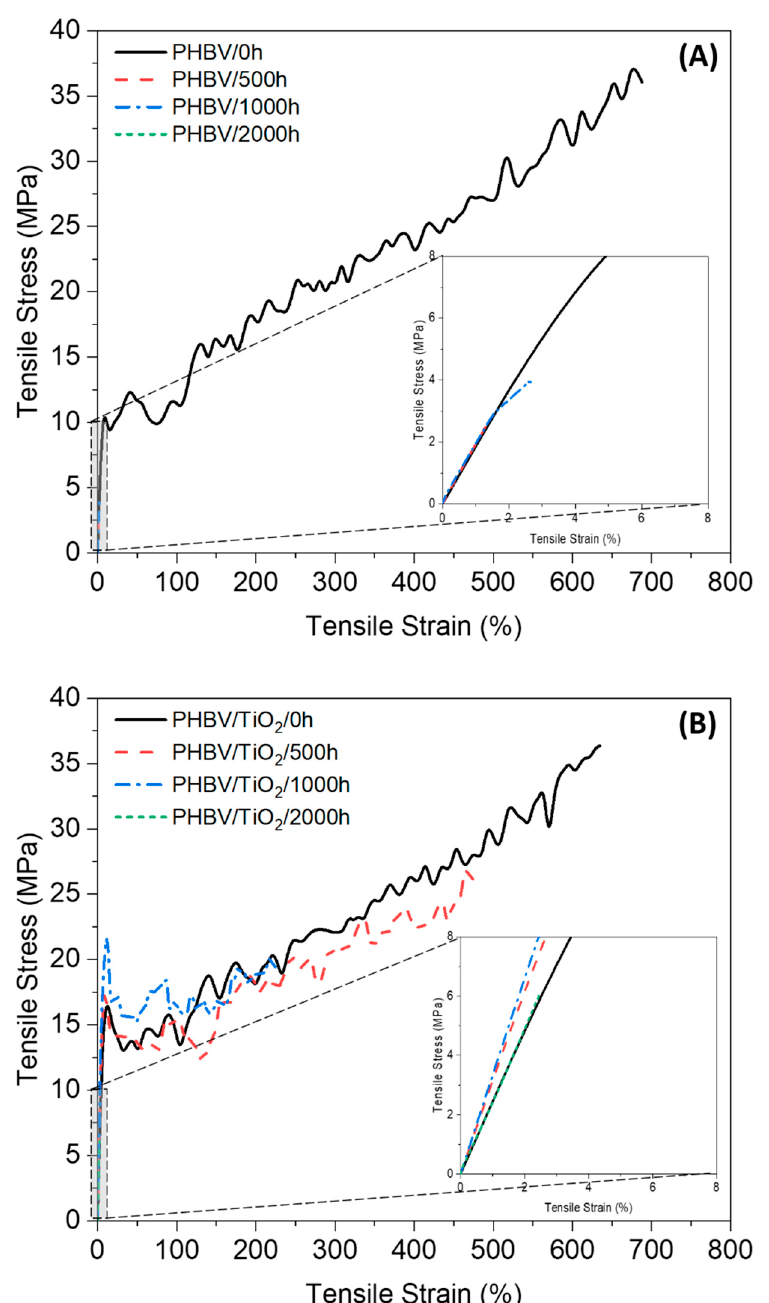
Figure 10. Representative tensile stress–strain curves of ( A ) the neat PHBV and ( B ) PHBV/TiO 2 samples after the different periods of accelerated weathering time.